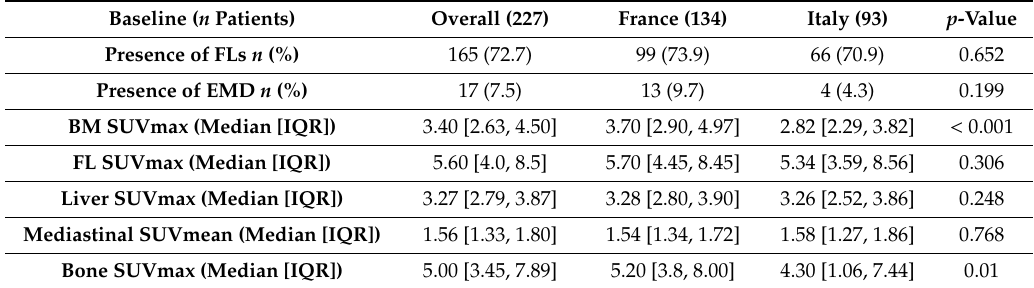
Table 2. Characteristics of FDG-PET / CT parameters at baseline (before